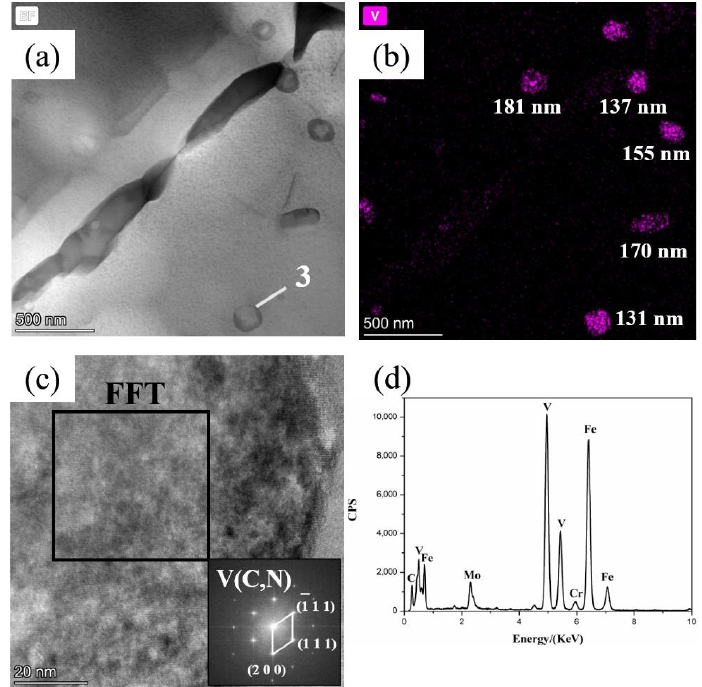
Figure 5. ( a ) Bright field micrographs of carbides in the RE‐H13 die steel, ( b ) the distribution of V element, ( c ) HRTEM micrographs of the nano‐scale carbide (the lower right inset shows the SAED patterns), ( d ) EDS analysis of V(C,N) precipitates after annealing.